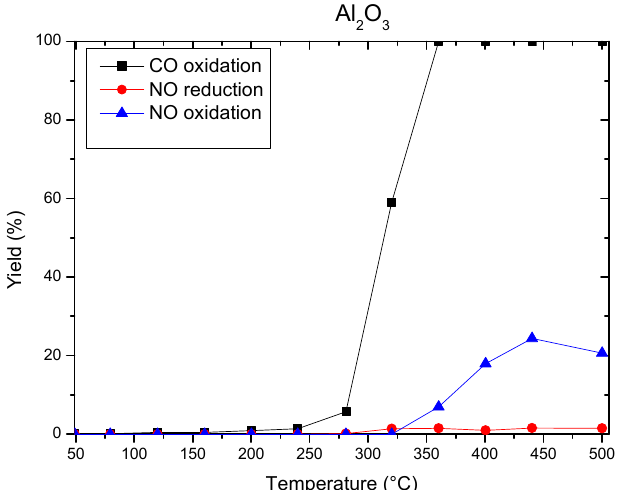
Figure 4. Light-off curves for Al 2 O 3 support and NO reduction or oxidation yield. Figure 4. Light-o ff curves for Al 2 O 3 support and NO reduction or oxidation